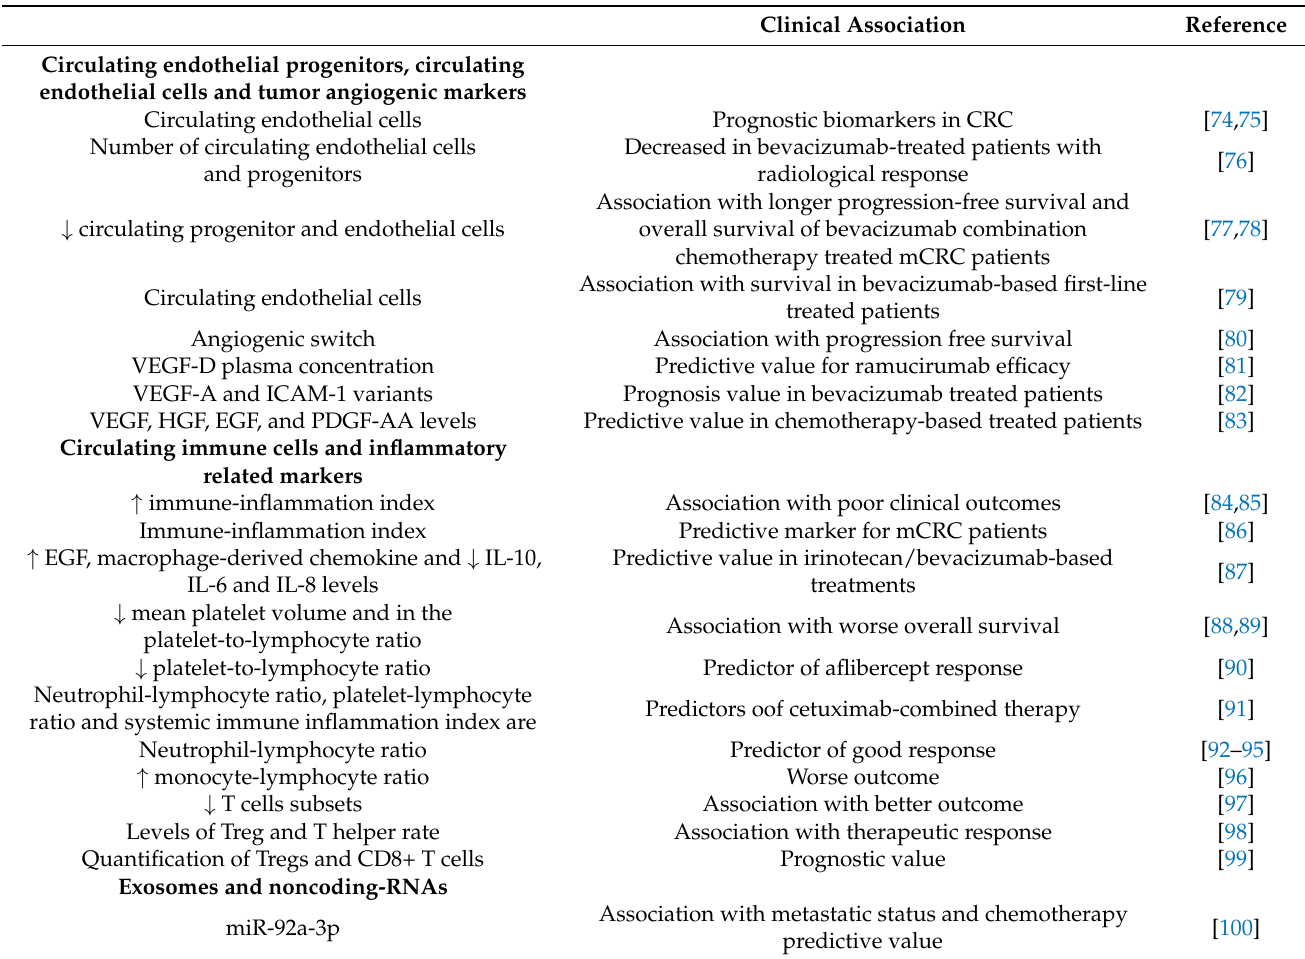
Table 3. Tumor microenvironment-derived markers in liquid biopsy of